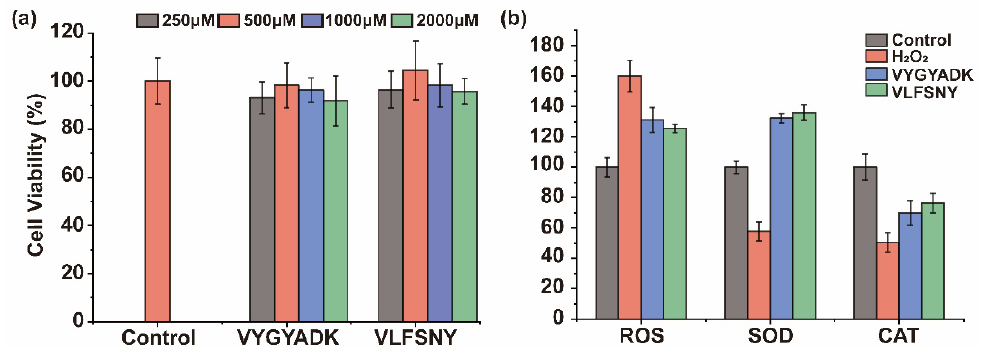
Figure 6. ( a ) The cell viability of different concentrations of synthetic peptides on Caco-2 cells; ROS content, ( b ) SOD and CAT activity. Different lowercases above the error bar denoted significant differences ( p < 0.05). The data shown mean ± SD ( n = 6).